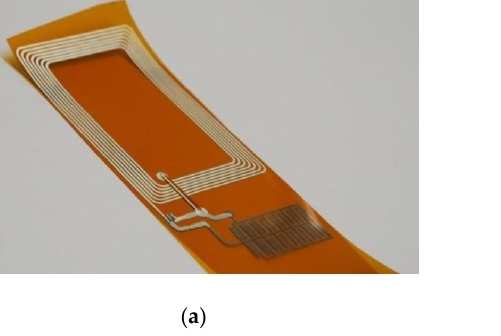
Figure 2. ( a ) Wireless sensor and ( b ) reader.